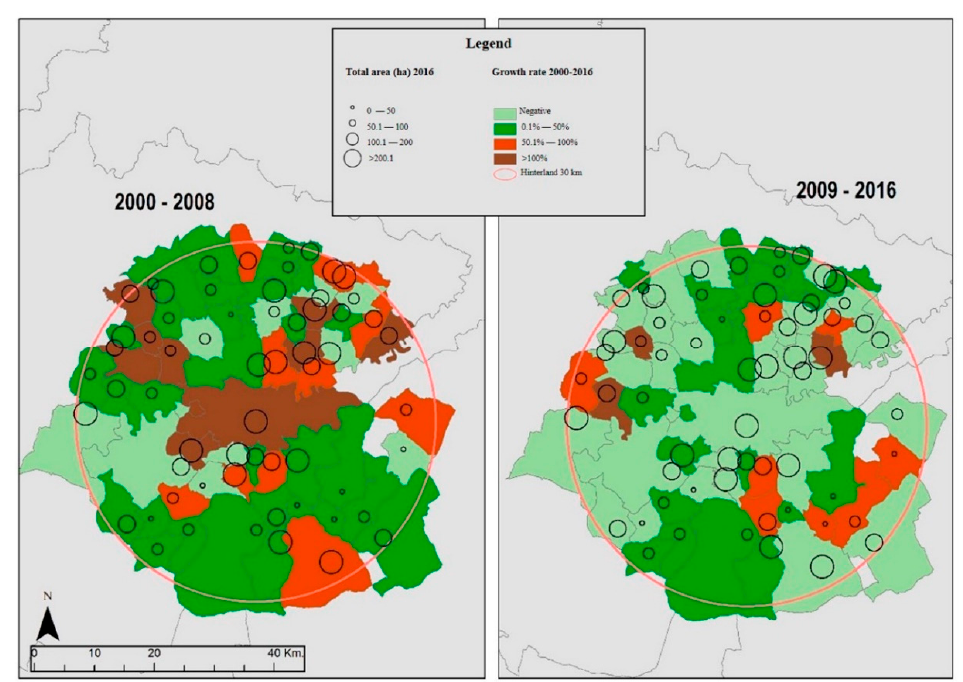
Figure 2. Growth rate of the built surface in the municipalities of the urban area of Toledo between 2000–08, and 2008-16. Source: Land Registry [64] and self-elaboration.